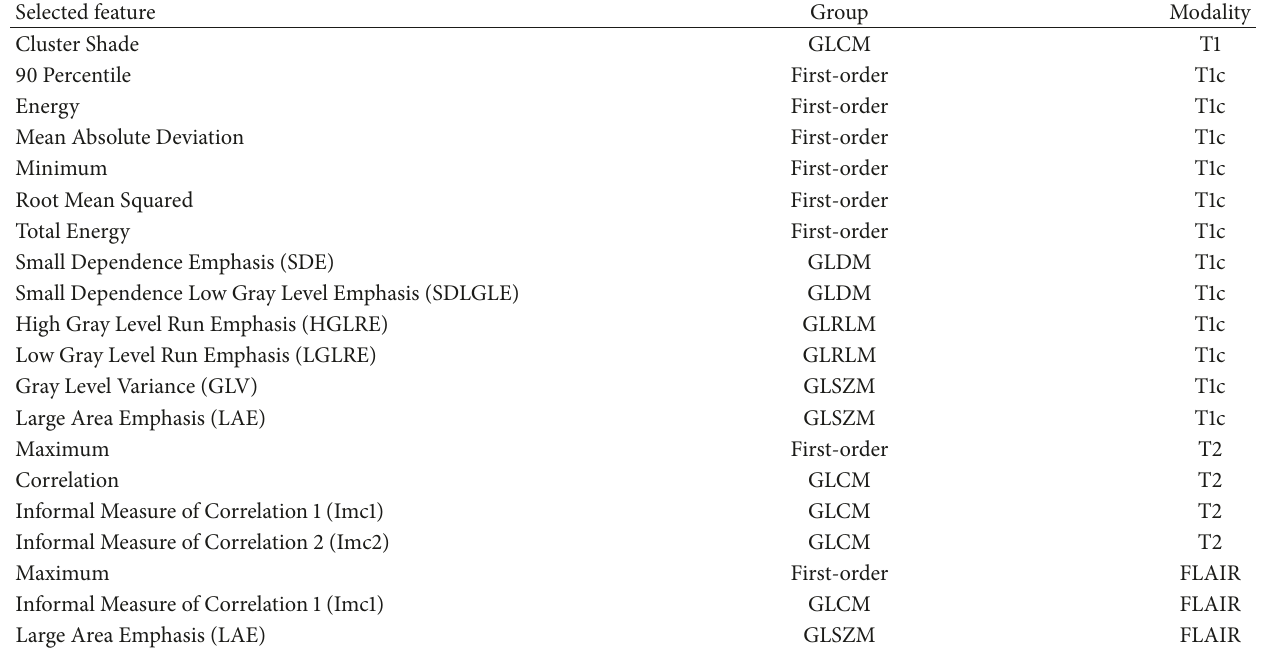
Table 3: The feature subset based on automated